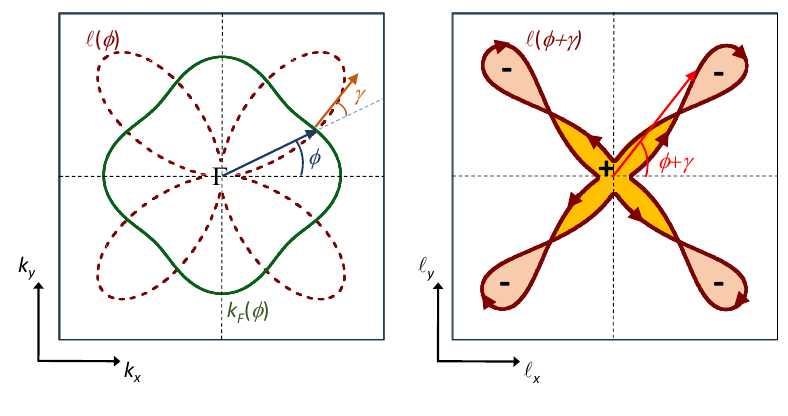
Figure 6: Left panel: Section of a 2D Fermi surface with pronounced negative curva- ( φ ) and the brown dashed ture. The solid green line indicates the Fermi surface k F line indicates a strongly anisotropic mean free path (cid:96) ( φ ) . The blue arrow indicates the direction and length of k while the orange arrow indicates the direction and F length of (cid:96) . Right panel: Polar plot of (cid:96) ( φ ) . The tangential arrows indicate the cir- culation of each loop and the − / + signs indicate the corresponding sign of the loop. The red arrow again indicates the direction and length of (cid:96) . The resultant σ is de- x y termined by the total area, i.e. the difference in the areas of the two counter-rotating loops.